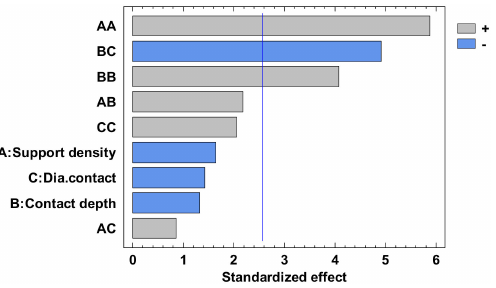
Figure 21. Standardized Pareto Chart for Straigtness_Y1.